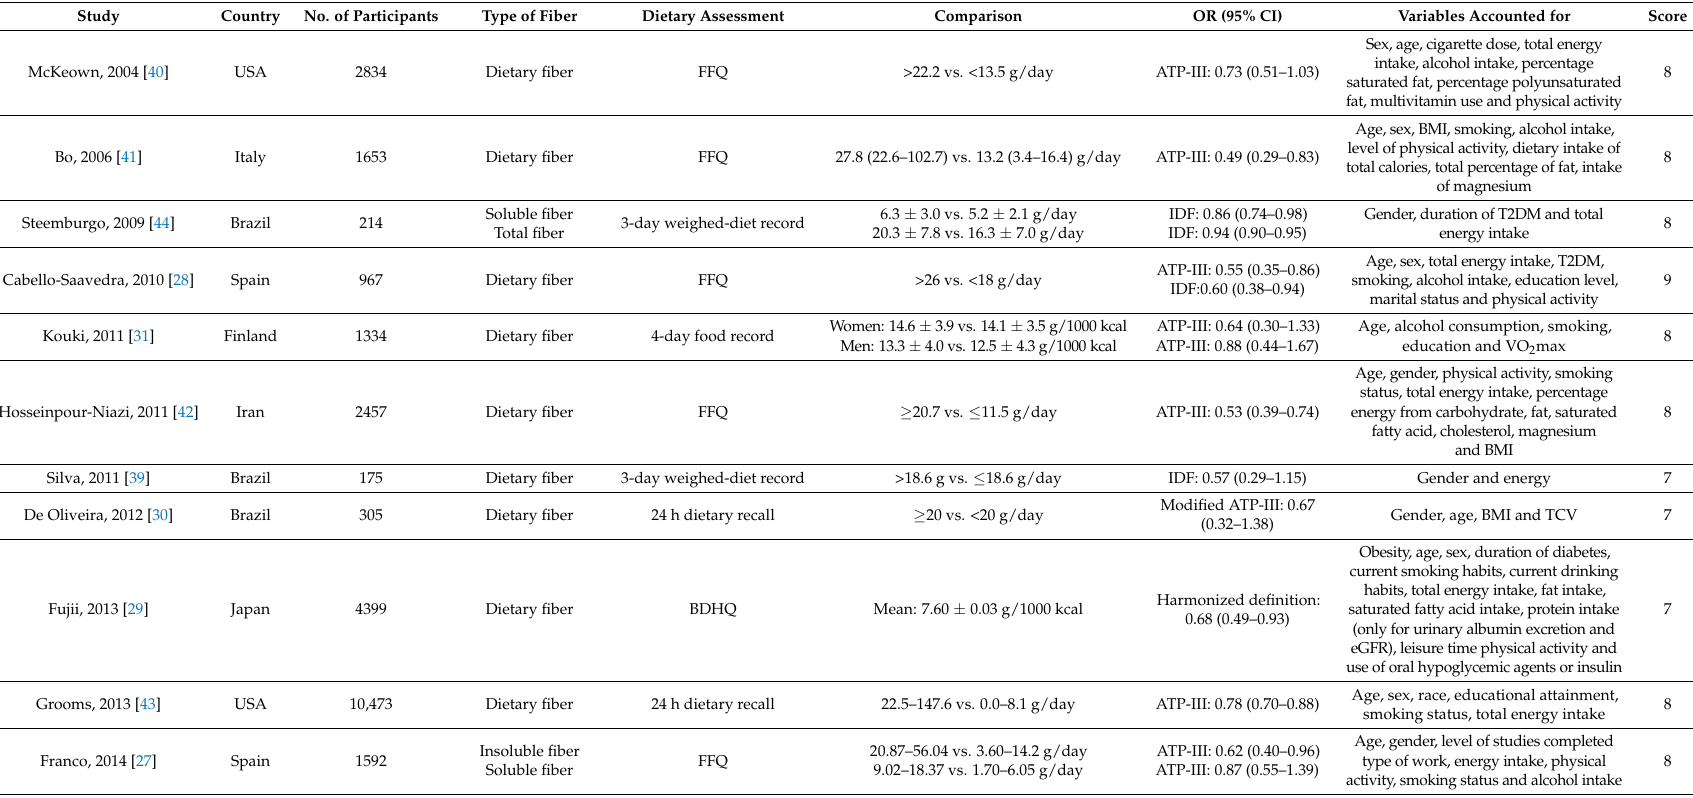
Abbreviations: ATP-III: Adult Treatment Panel III of the National Cholesterol Education Program; IDF: International Diabetes Federation; FFQ: food frequency questionnaire; BDHQ: brief self—administered diet history questionnaire; T2DM: type 2 diabetes mellitus; OR: odds ratio; CI: confidence interval; BMI: body mass index; TCV: total caloric value; Score was rated using a 11-item checklist that was recommended by Agency for Healthcare Research and